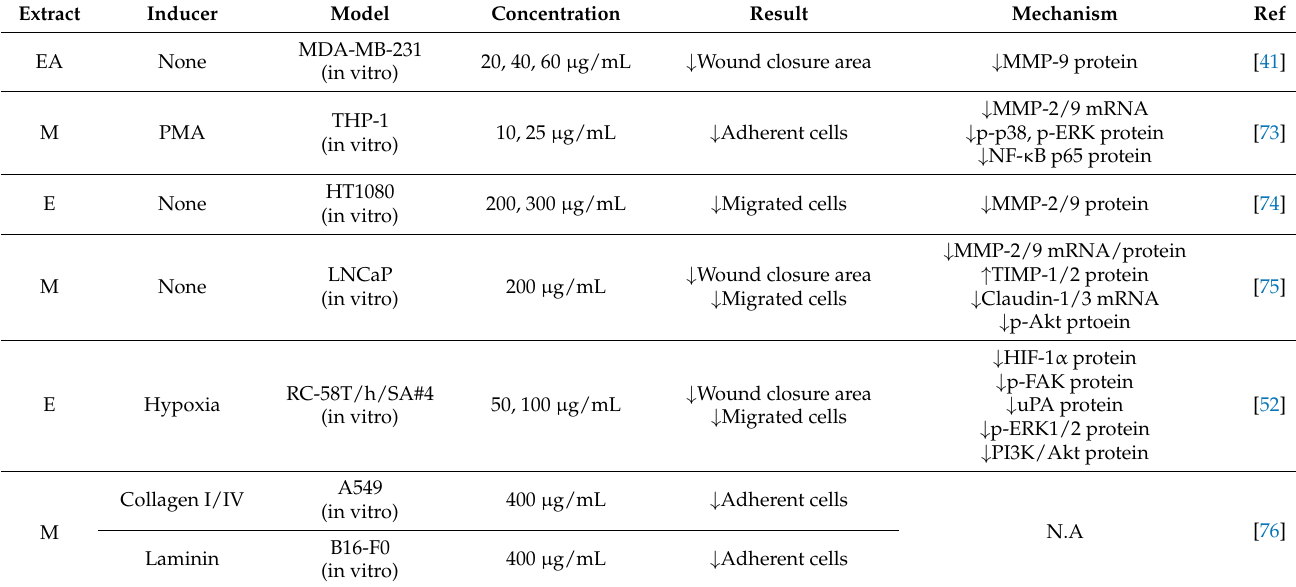
Table 3. Antimetastatic effects and molecular mechanisms of O.